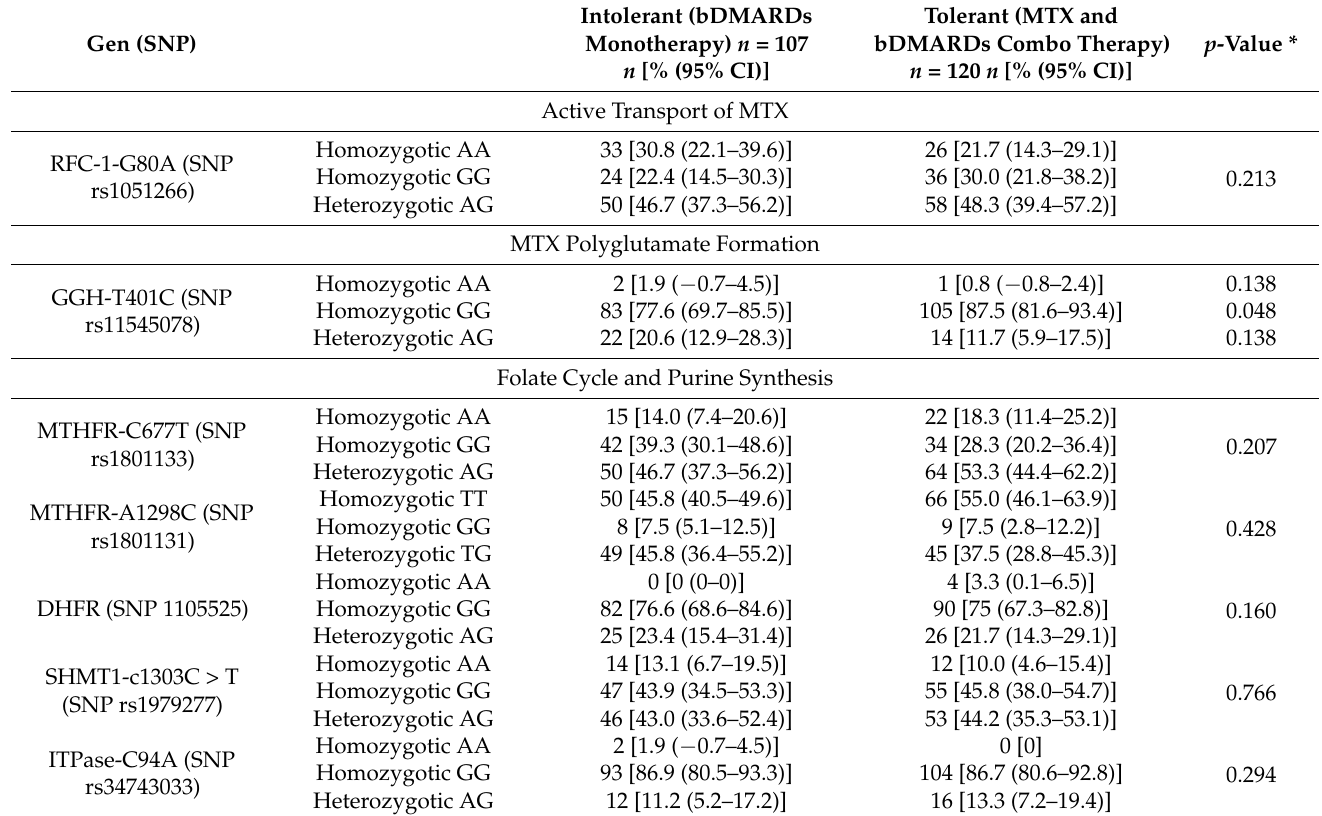
Table 2. Association between methotrexate intolerance and